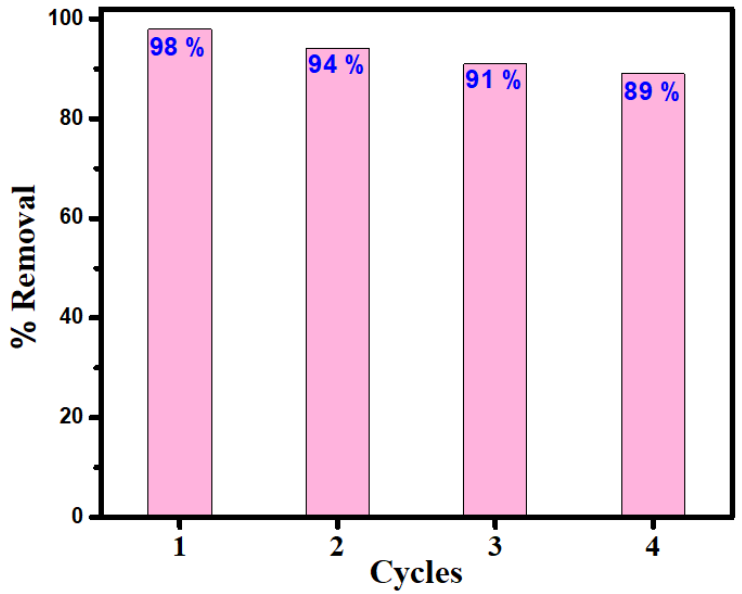
Figure 9. Reusability effectiveness of CaO-g-C 3 N 4 .